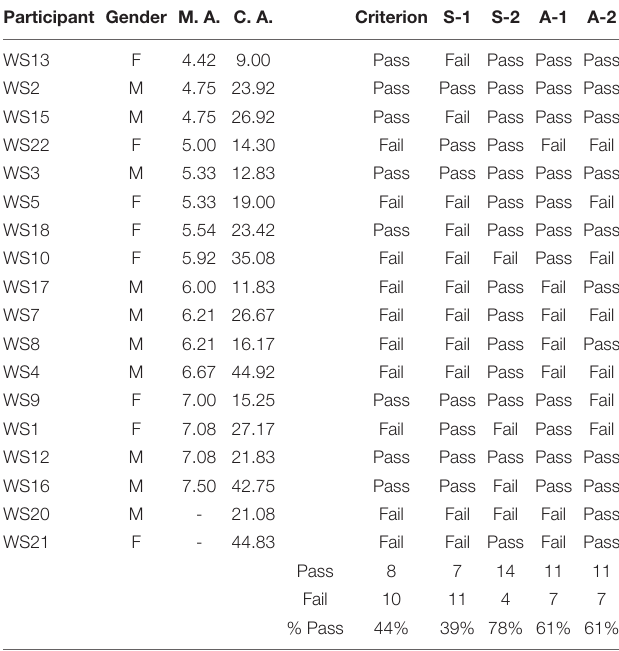
difference in the number of participants with DS and the